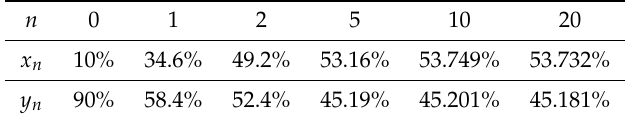
Table 12. Values of the iterated sequence ( x n , y n ) if started with ( 10%,90% ) . n